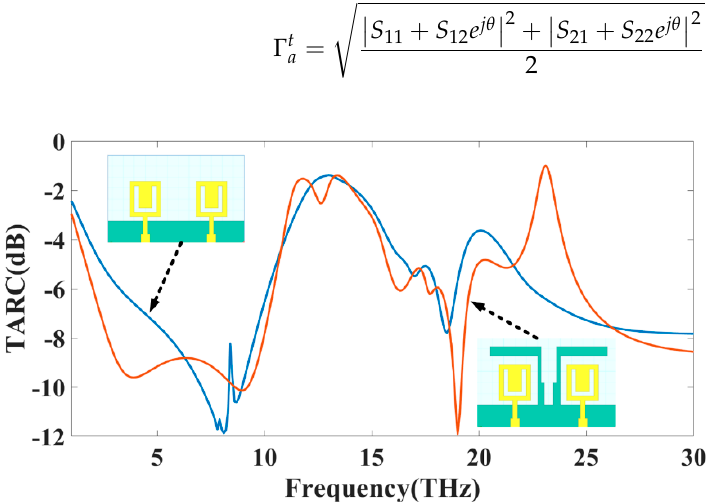
Figure 6. The simulated value of the TARC (dB) for MIMO structure Design 3 and Design 4.